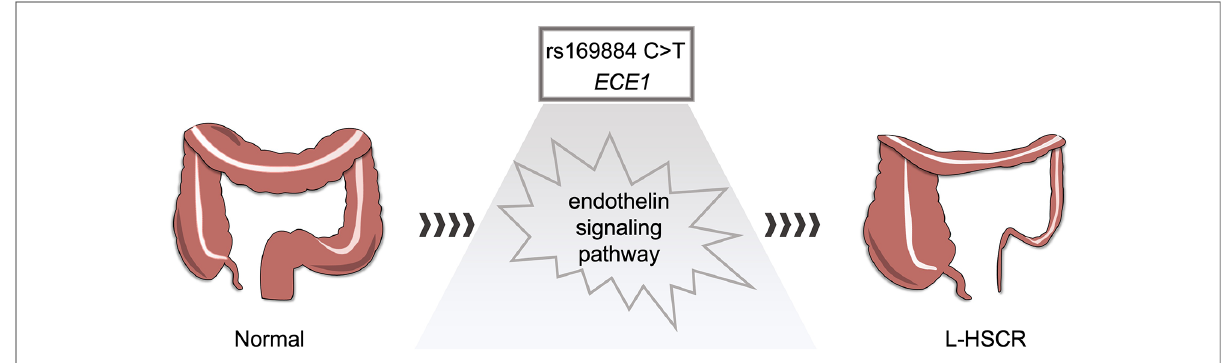
FIGURE 2 Hypothesis of rs169884 risk on L-HSCR. rs169884 may regulate the expression of ECE1 , which further causes abnormal development of enteric nervous system through the endothelin signaling